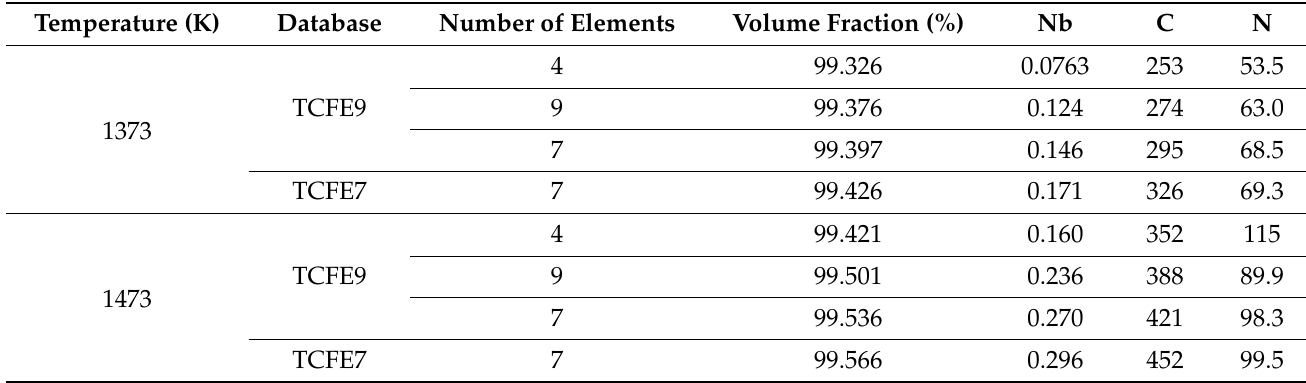
Table 3. Equilibrium contents of Nb (wt.%), C and N (wt. ppm) in austenite as well as austenite volume fraction at 1373 and 1473 K obtained using the TCFE7 and TCFE9 databases for different numbers of elements considered in the composition of 316Nb steel. (The contents for other elements were close to the actual steel composition.) Temperature